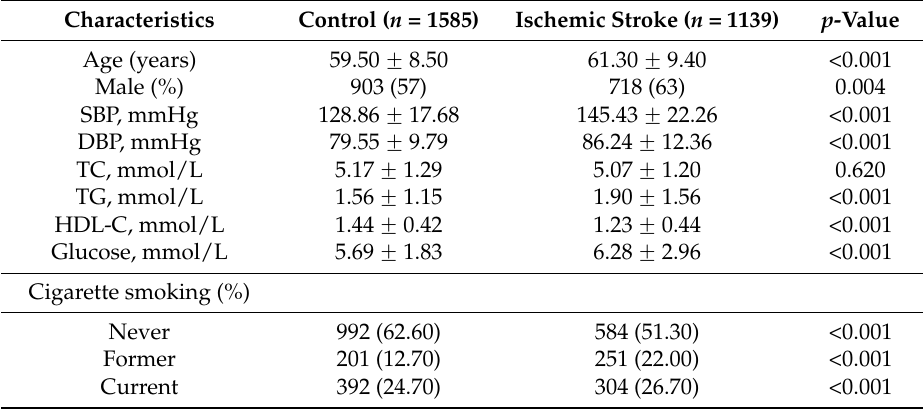
Table 1. Baseline characteristics of the study